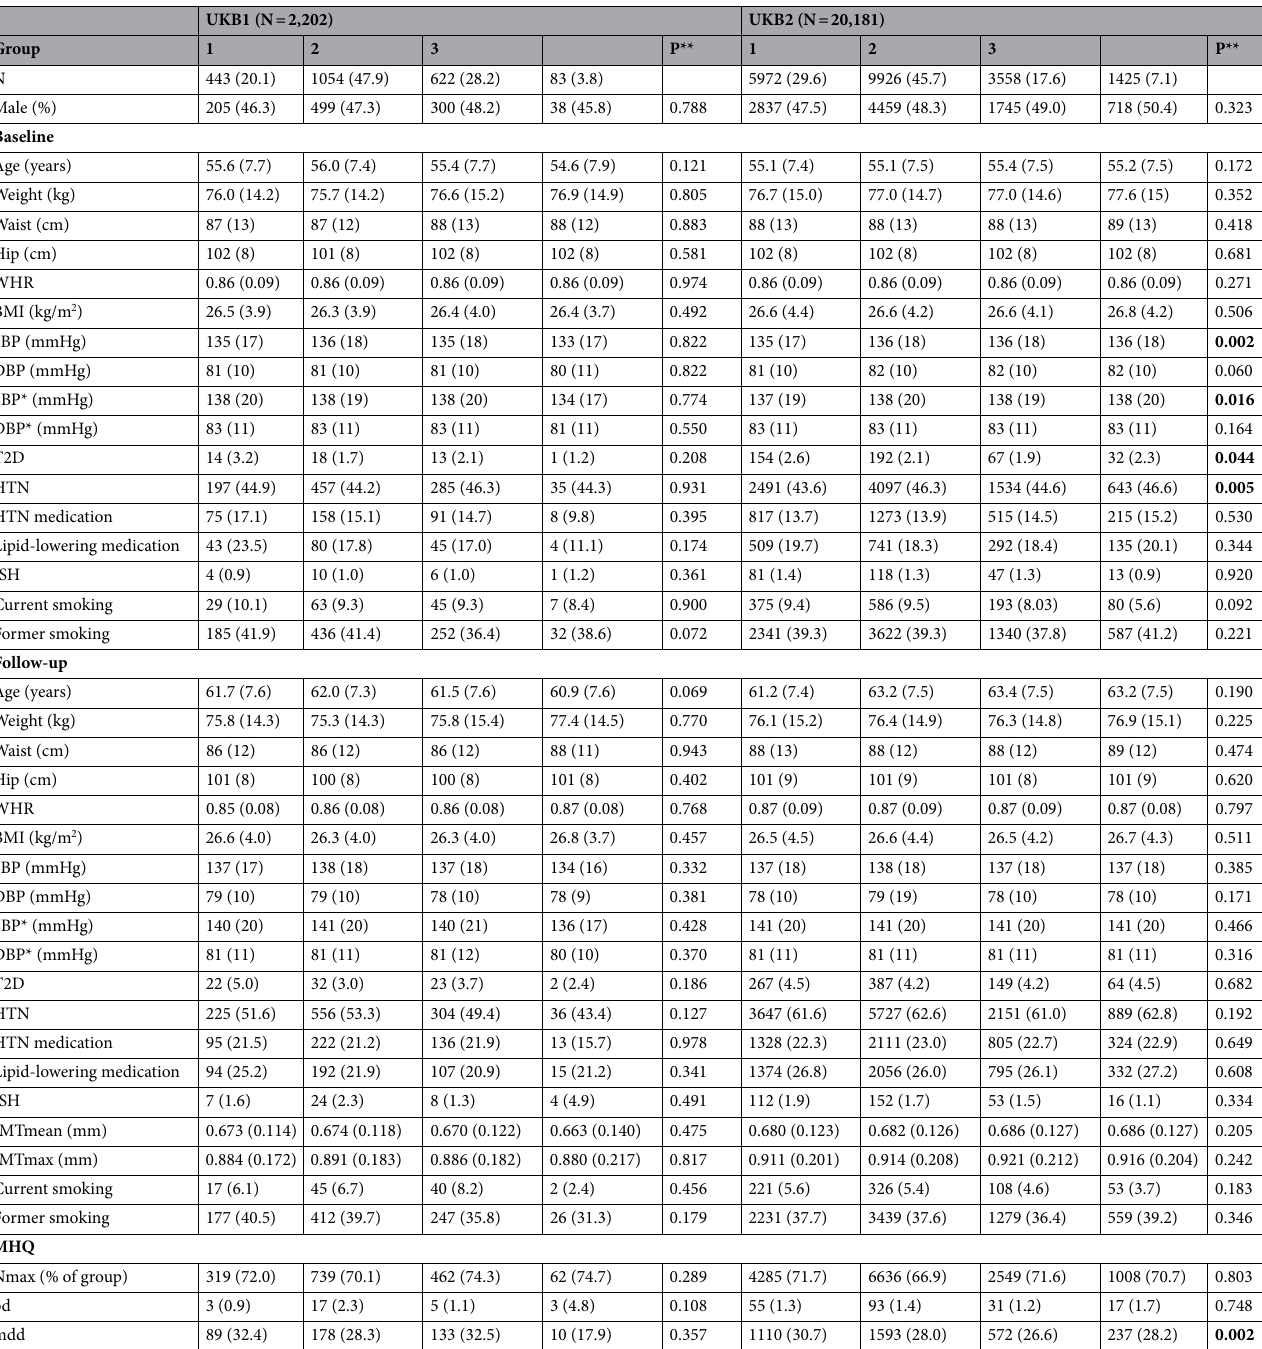
Table 3. Demographic characteristics of the UKB1 and UKB2 participants, by cluster. Highlighted in bold are the significant (p < 0.05) differences between groups. Where: *, adjusted to provide estimates of treatment- naïve levels; na, not available; Statistical analyses compared levels or frequencies across groups 1, 2 and 3. Ungrouped (.) were omitted from the analyses). ** P for Pearson’s chi square for categorical variables and Kruskal–Wallis for continuous